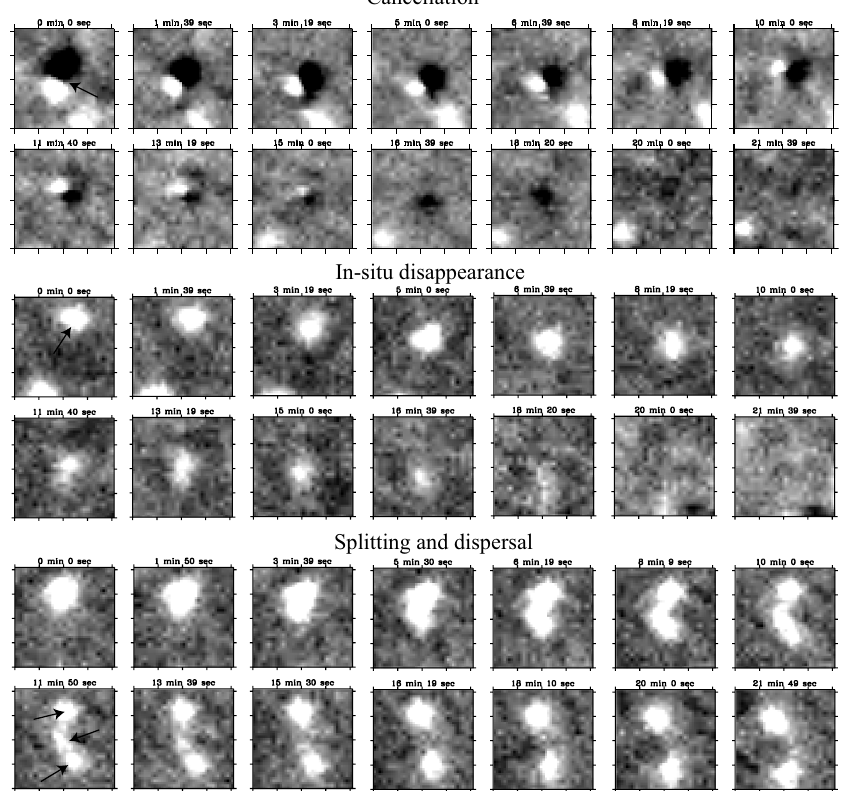
Fig. 21 Examples of cancellation, in-situ disappearance, and fragmentation of flux features observed in Hinode/NFI magnetograms. White represents positive polarity. The magnetograms are saturated to ± 30Mx cm − 2 to better follow the evolution of the flux. The measurements were taken in the framework of Hinode Operation Plan 151. Tickmarks are separated by 1 (cid:2)(cid:2)